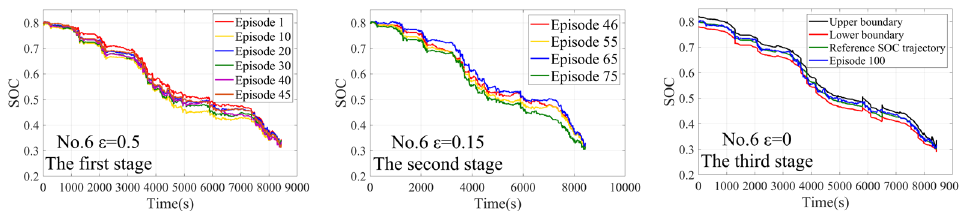
Figure 14. The training process of combined driving cycle 5.